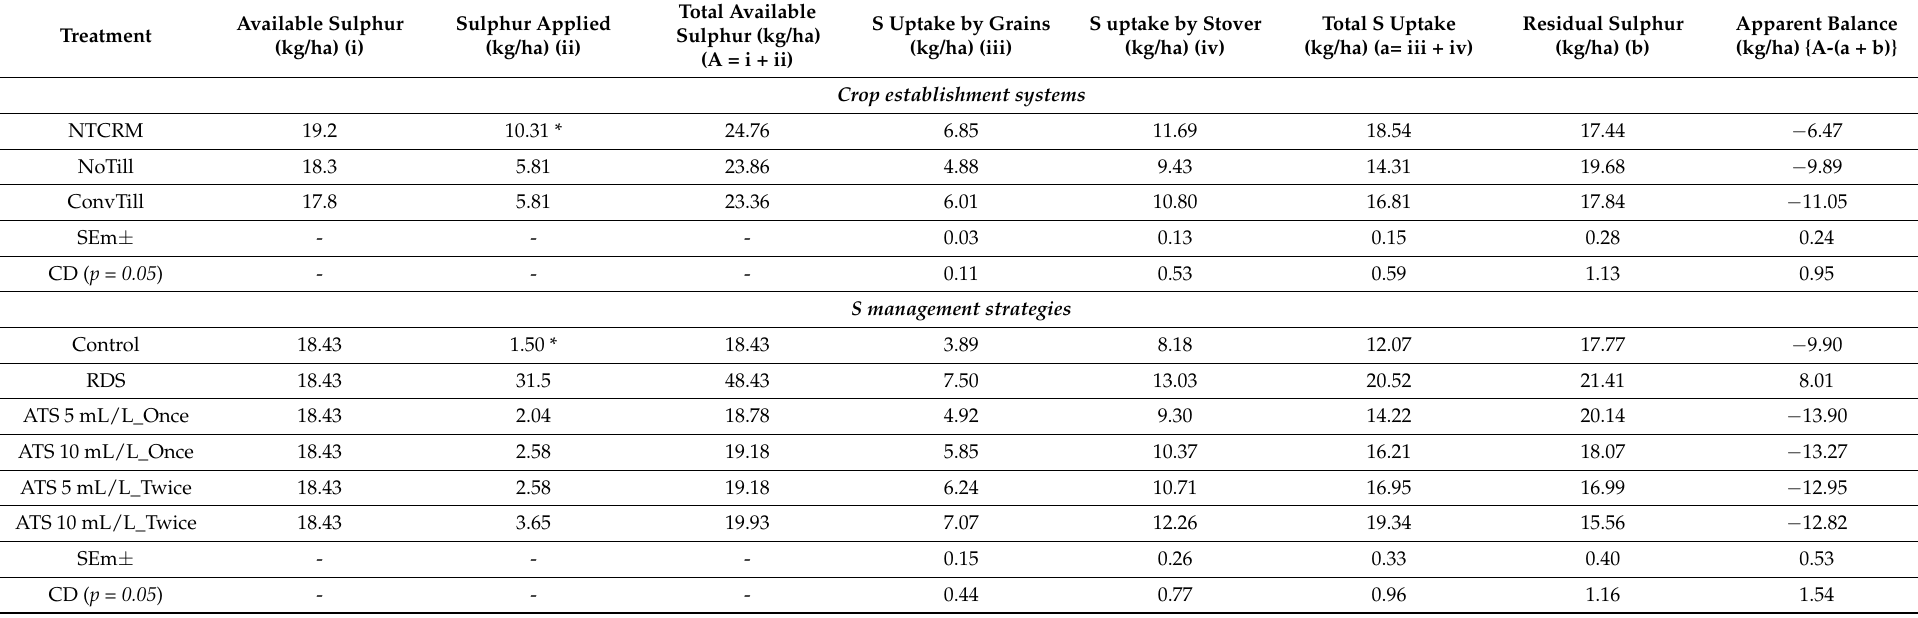
Table 3. Sulphur economy (mean of two years of